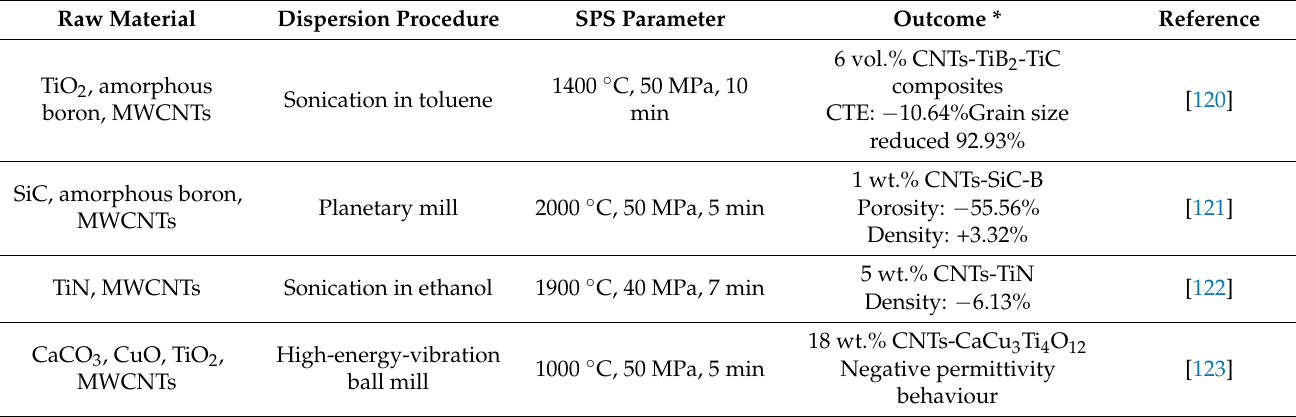
Table 6. Previous work on CNTs-CMCs composite via SPS